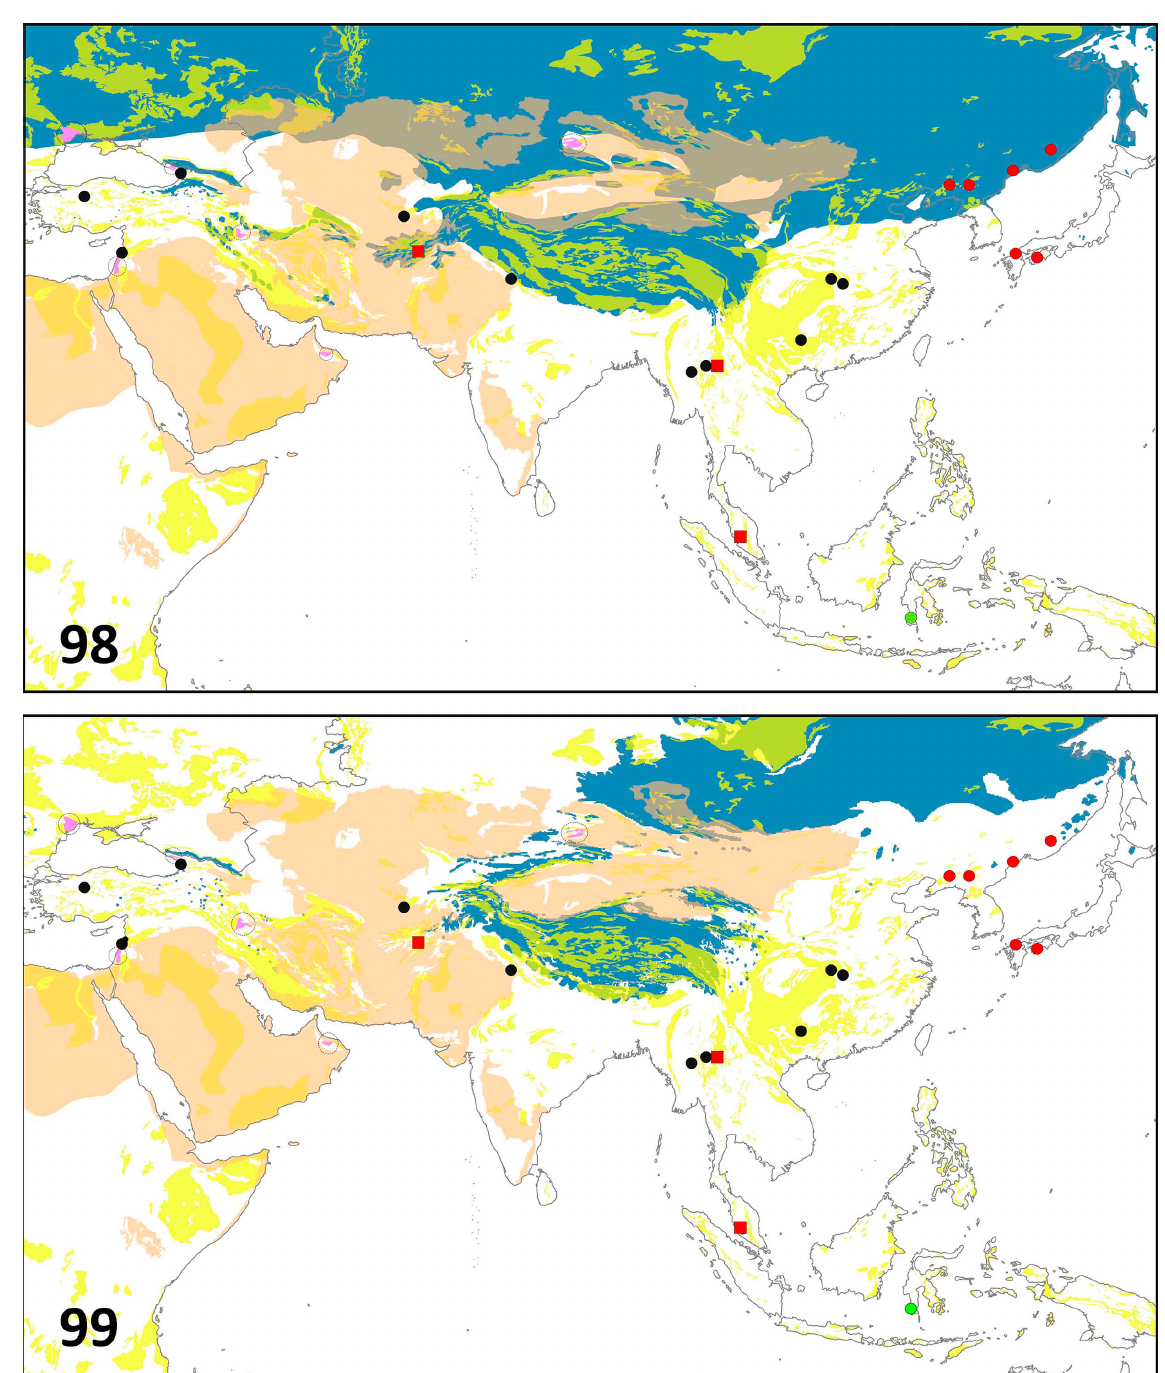
Figure 98‒99. Distribution maps of cave-adapted diplurans in Asia: Campodeinae Condé, 1956 (red circles), Plusiocampinae Paclt, 1957 (black circles), Lepidocampinae Condé, 1956 (brown circles), Japygidae Haliday, 1864 (red squares). In yellow: karst areas (source: Chen et al . 2017). In orange: deserts (source: Olson & Dinerstein 2002). In violet, encircled by discontinued line: hypogean karst systems (source: Klimchouk 2007). 98 . In blue: ice cover and permafrost extent during the Last Glacial Maximum (sources: Ehlers et al . 2011; Lindgren et al . 2016). 99 . In blue: areas covered with either continuous or patched permafrost at present (source: Brown et al .